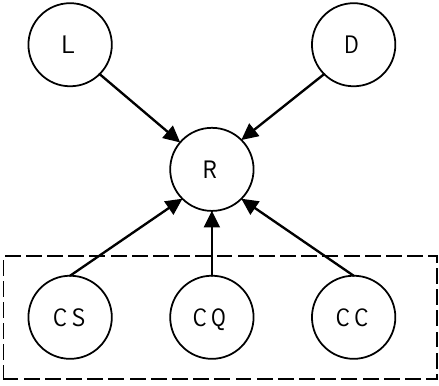
Figure 5. Bayesian topology of risk